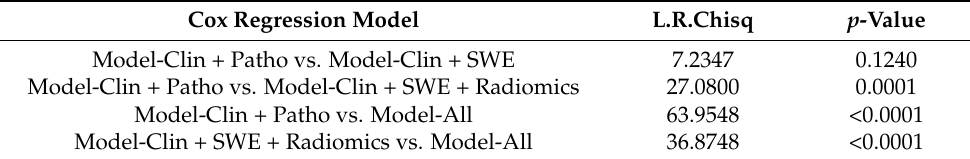
Table 3. Comparison of Cox regression